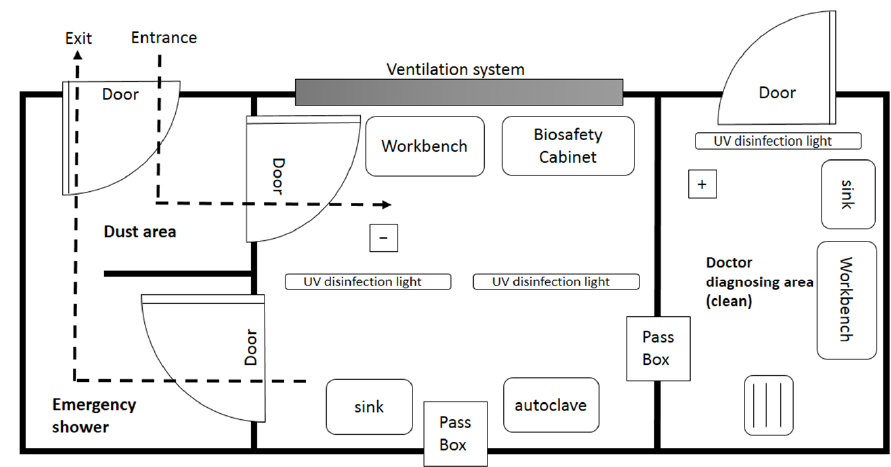
Figure 6. Layout of the mobile